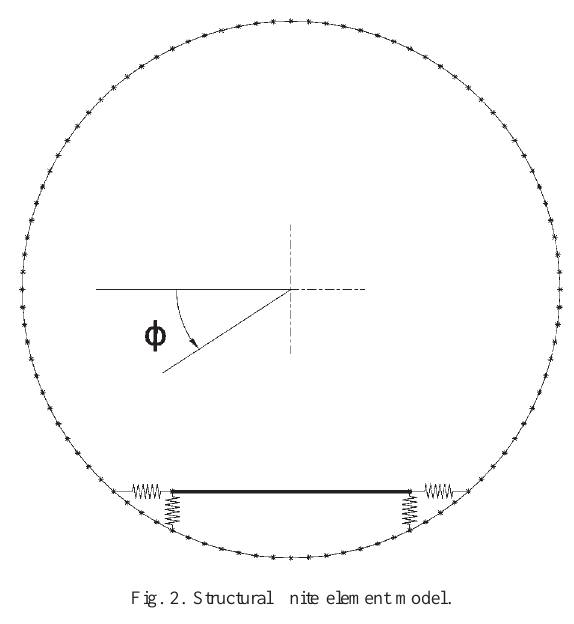
Fig. 2. Structural finite element